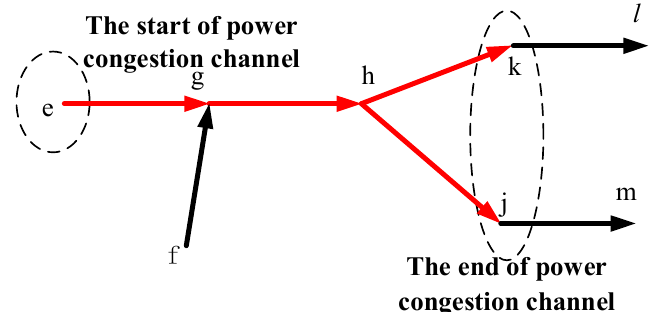
Figure 3. Diagram sketch of congestion channel.